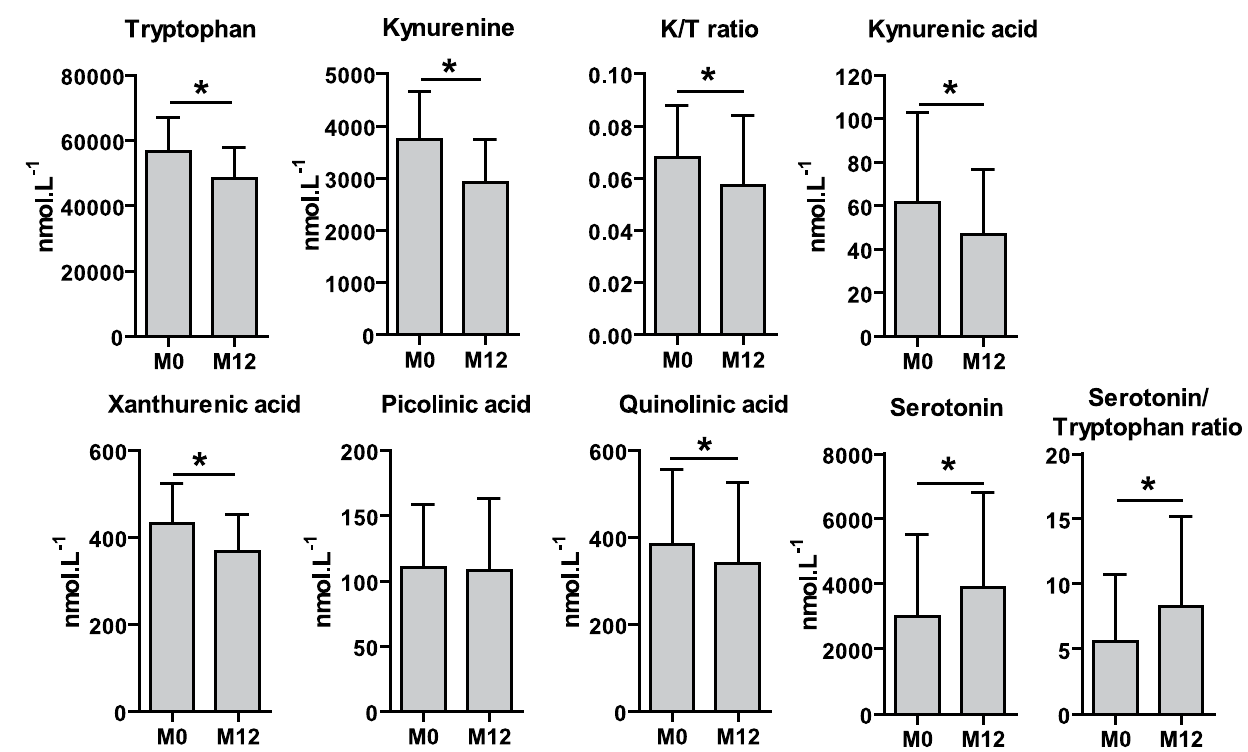
Fig 3. Tryptophan, serotonin, KPm concentrations, K/T ratio and serotonin over tryptophan ratio in the serum of women with obesity at inclusion and 12 months after bariatric surgery. Data are presented as mean ± SD; Mann-Whitney test was used for statistical analyses, * statistically significant at 0.05 after a Benjamini-Hochberg correction for multiple testing.